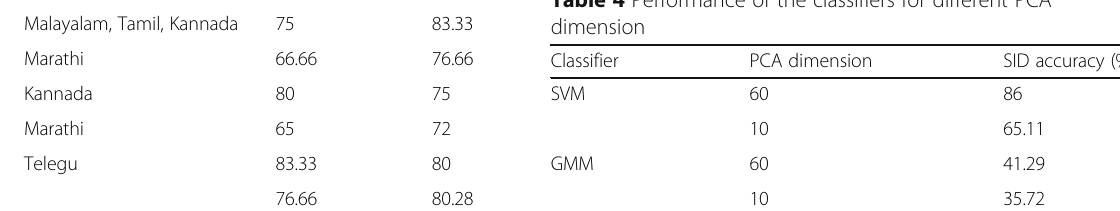
Table 4 Performance of the classifiers for different